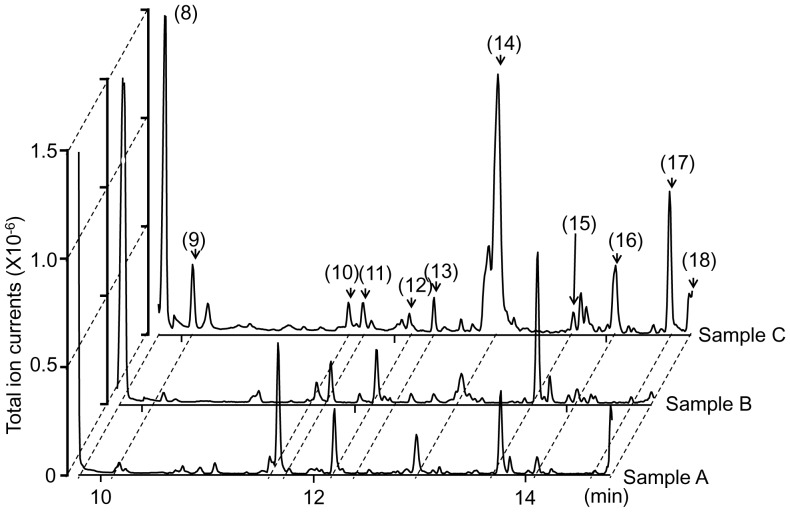
Chromatograms from GC-MS analyses of wolf urine samples.Numbers refer to the following compounds: (8) Δ3-isopentenyl methyl sulphide; (9) 1-(methylthio)-2-methylbut-2-ene; (10) 3-buten-1-ol, 3-methyl-; (11) 4-methyl-3-heptanone; (12) 2,4-dithiapentane*; (13) 1-pentanol, 2-methyl-; (14) pyrazine, 2,6-dimethyl- (DMP)*; (15) dimethyl trisulphide*; (16) pyrazine, trimethyl- (TMP)*; (17) pyrazine, 3-ethyl-2,5-dimethyl (EDMP)*; (18) acetic acid*. *Identified by GC-MS (n = 6) and a comparison with the retention times of identified chemicals.